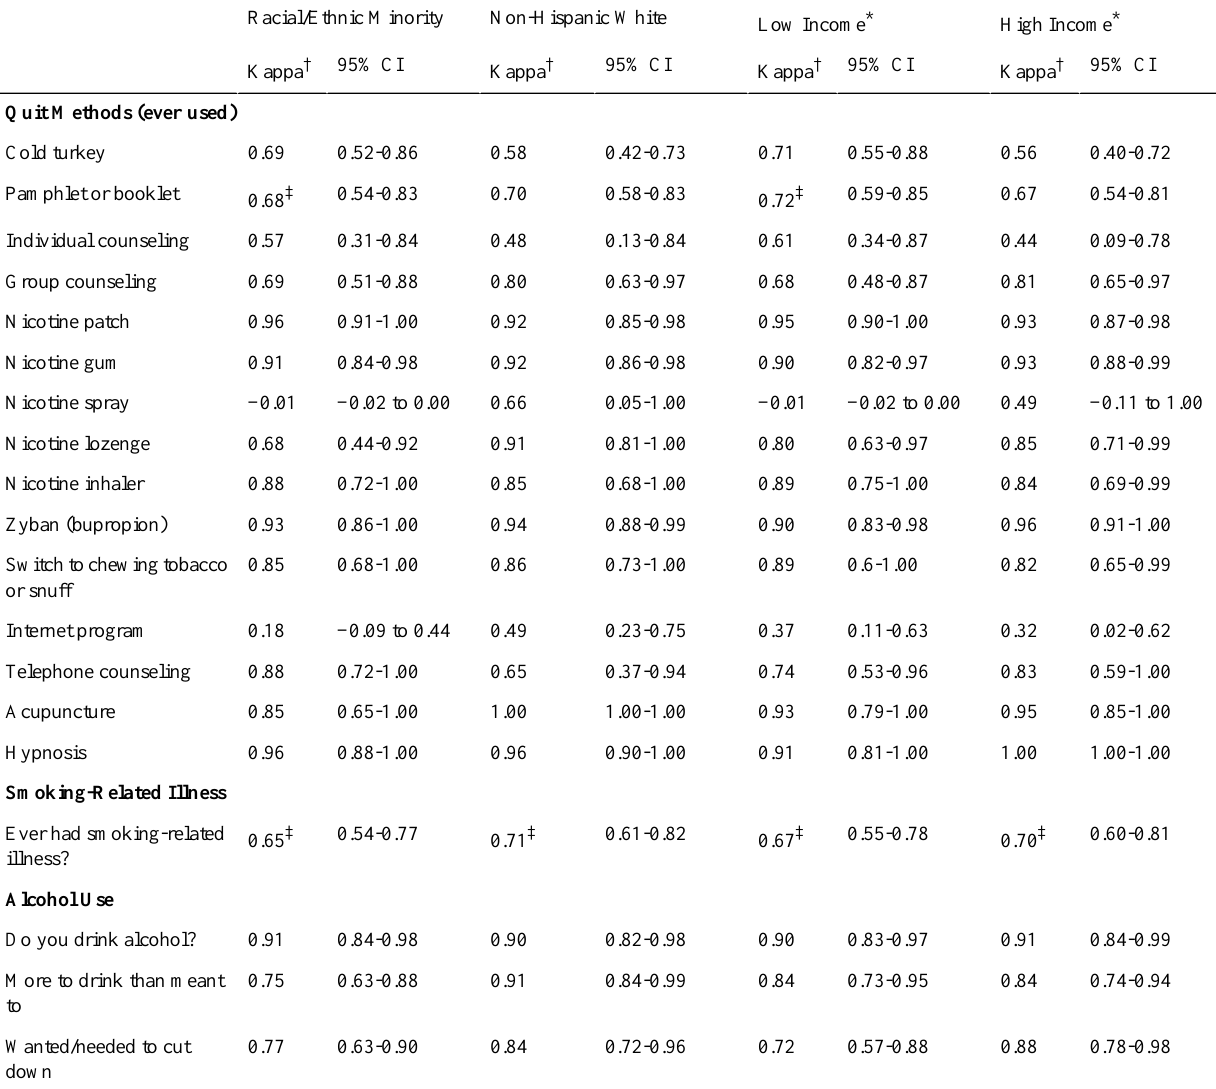
Table 2. Internet–telephone reliabilities of binary variables by race/ethnicity and income